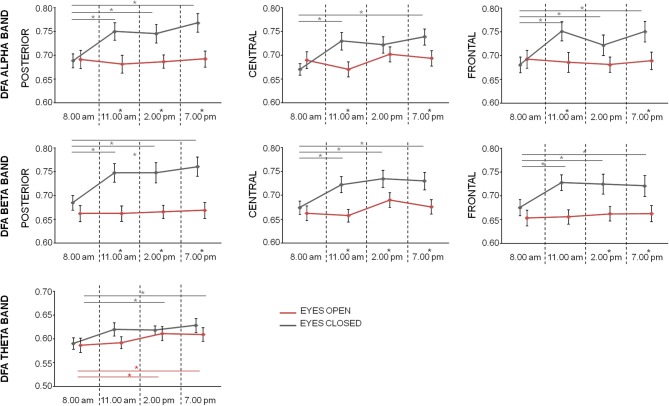
Mean (bars indicate standard error of mean) of DFA exponent values in the different regions for alpha, beta, and theta bands at the 4 times in closed eyes (gray) and open eyes (red) conditions. Significances of the paired t-test between times are shown (gray for closed eyes and red for open eyes; *p < 0.05, FDR corrected). The difference between eyes closed and eyes open conditions at one time is evidenced by a star as apex of corresponding time.